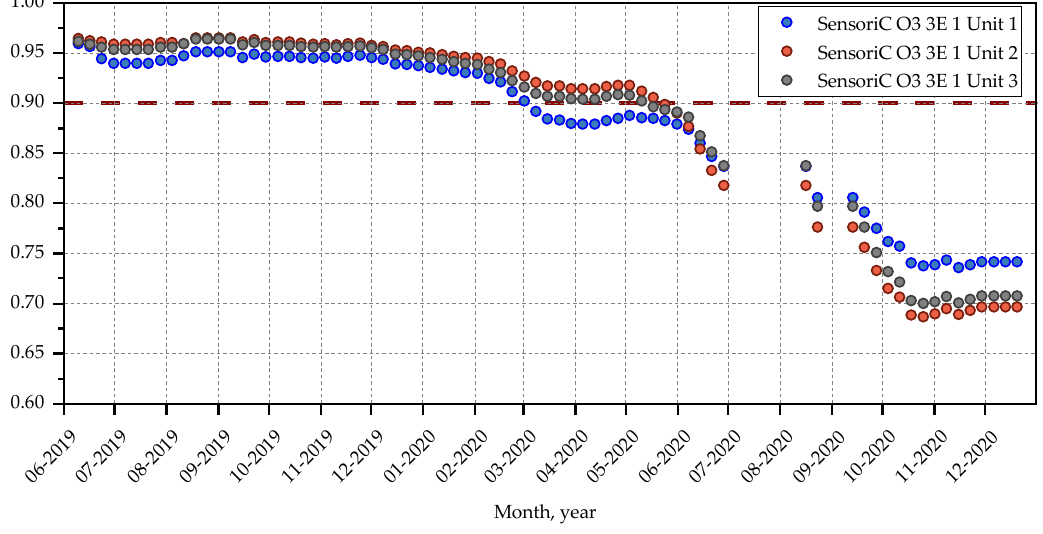
Figure 4. Changes in R 2 from linear fittings for the SensoriC O3 3E 1 sensor and the reference O 3 analyser over successive weeks of the study. The dashed line indicates an R 2 coefficient of 0.9, which was assumed as an indicator of the good quality fitting.